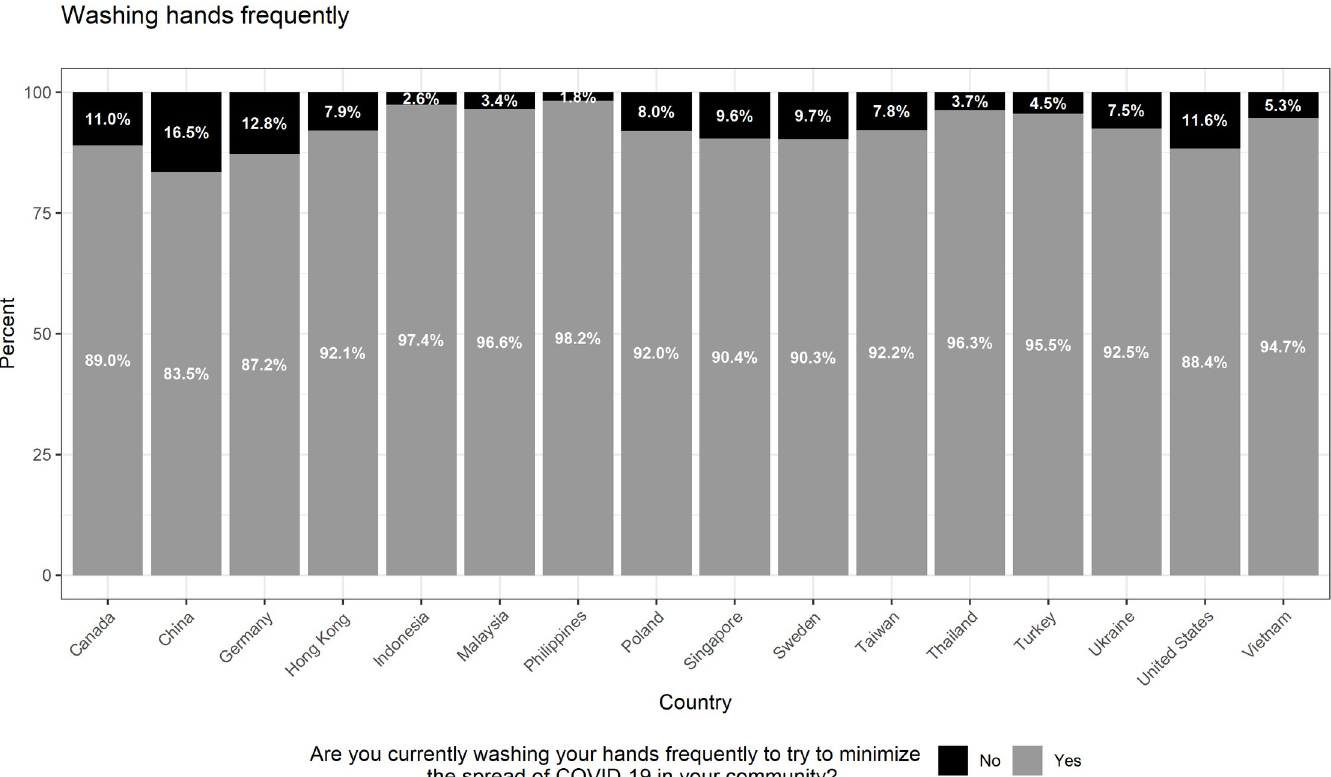
Fig 2. Self-reported hand washing by country/territory. This figure summarizes individual responses (yes, no), by country/territory, regarding whether they have been washing their hands more often to try to minimize the spread of the COVID-19 in their community. Sample size by country/territory: Canada = 1077; China = 1177; Germany = 1056; Hong Kong = 582; Indonesia = 1097; Malaysia = 959; Philippines = 1160; Poland = 1107; Singapore = 541; Sweden = 1058; Taiwan = 759; Thailand = 1105; Turkey = 1108; Ukraine = 1101; United States = 1228; Vietnam = 1048.